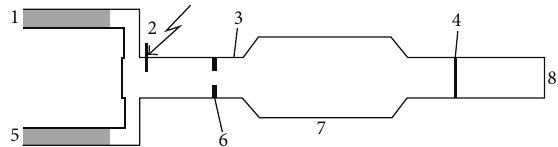
Figure 7: Schematic view of pulse detonation engine: 1 and 5: fuel andoxidantfeedmanifolds,2:sparkplug,3:combustionchamber,4: detonation wave, 6: ring obstacle, 7: prechamber, and 8: nozzle [34].